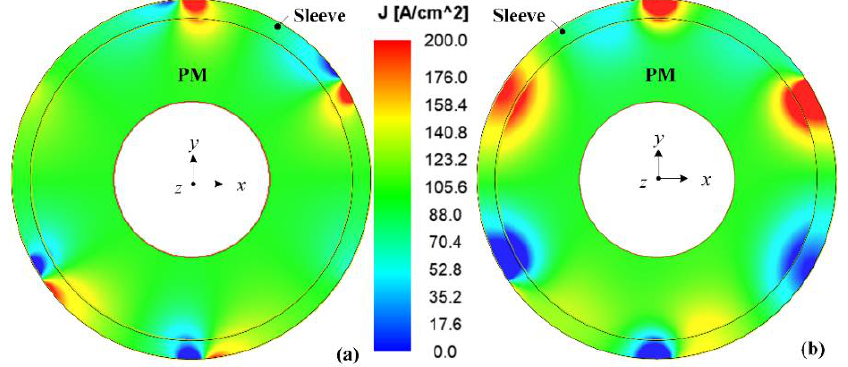
Figure 7. Distribution of eddy current density according to the current waveform: ( a ) sinusoidal and ( b ) PWM current.